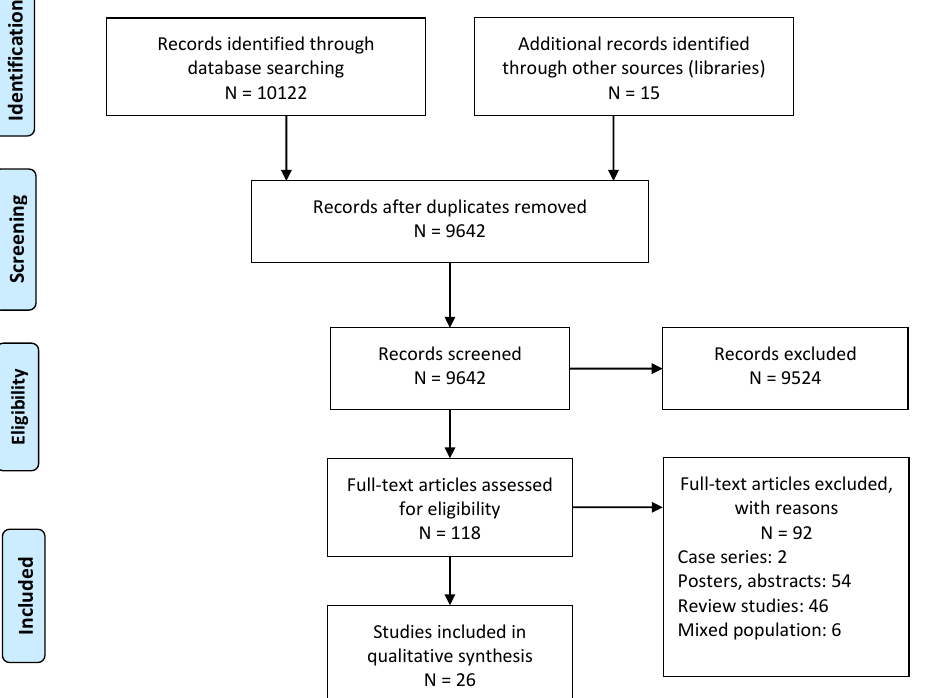
Figure 1. This is a figure. Schemes follow the same formatting. Figure 1. Illustrating the PRISMA flow chart for the included